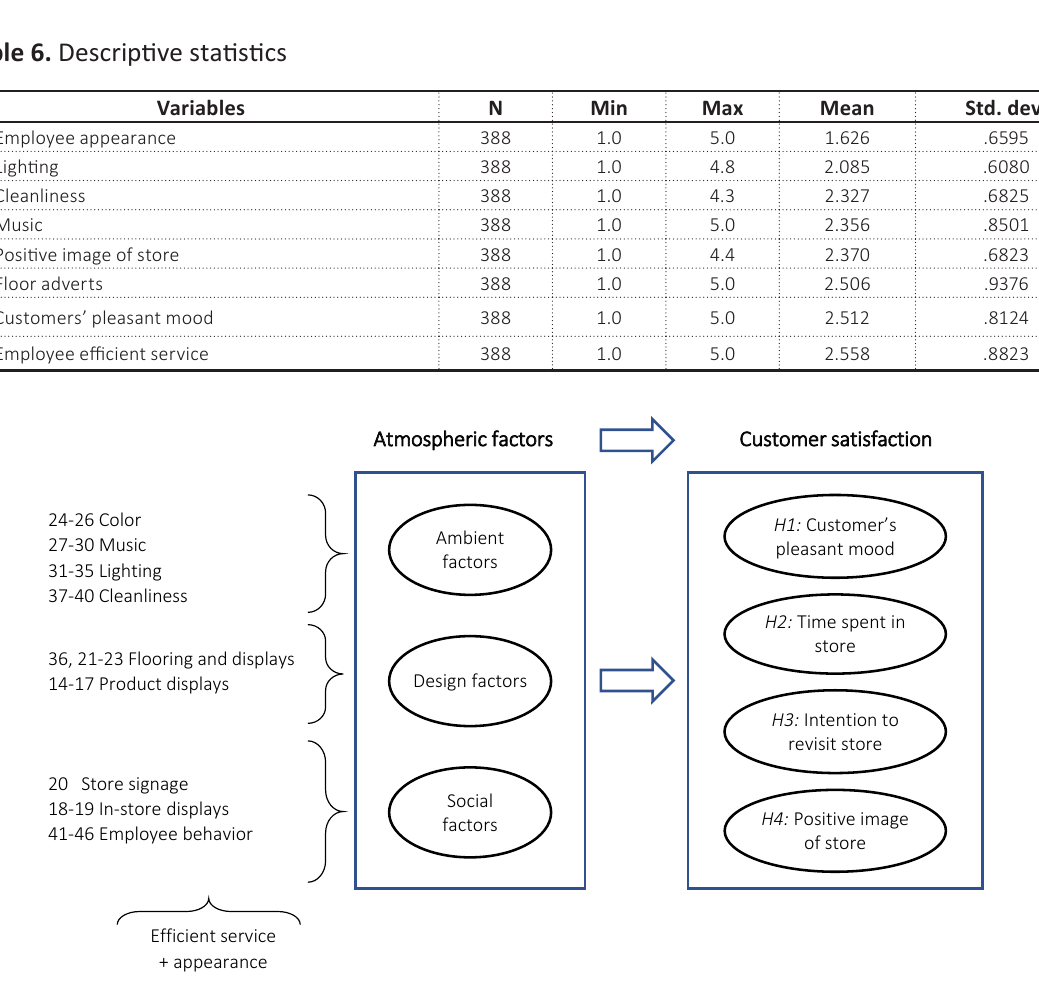
Figure 2. Revised conceptual